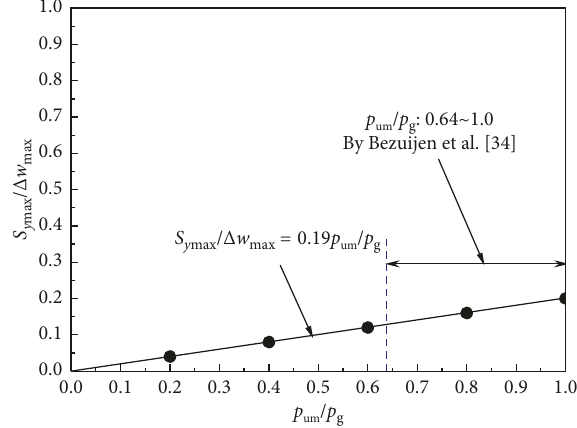
Figure 8: Normalized vertical displacement of ground surface versus the ratio of uniform pressure acting at the soil-grout in- terface to grouting